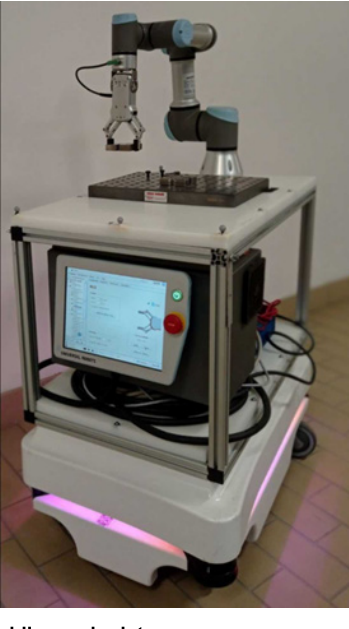
Figure 1. Mobile